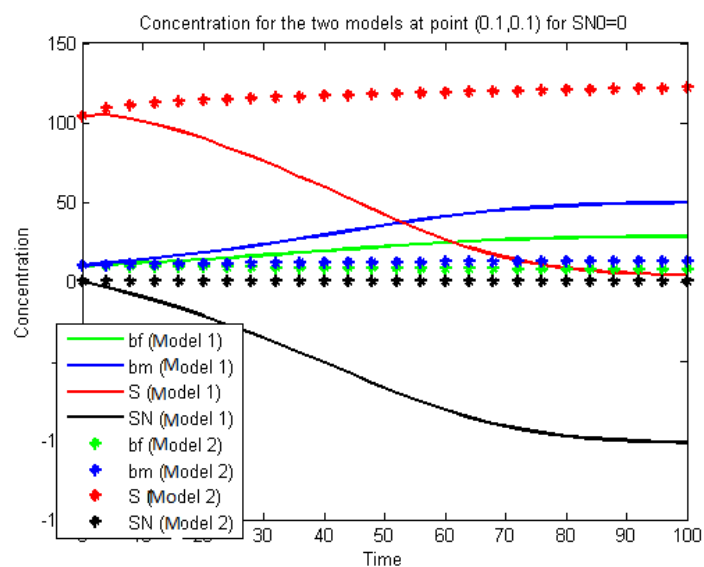
Figure 3. Concentrations for Models 1 and 2 at point (0.1, 0.1) for S in